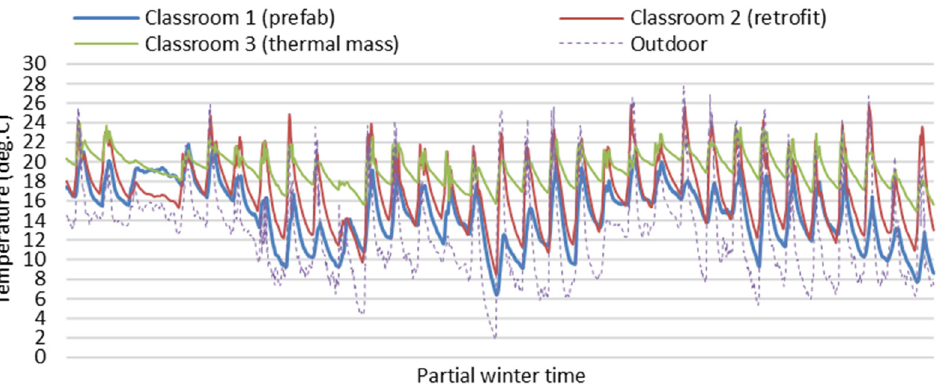
Figure 4. Field study data of indoor temperatures of the three classrooms on partial winter days (24 h per day).